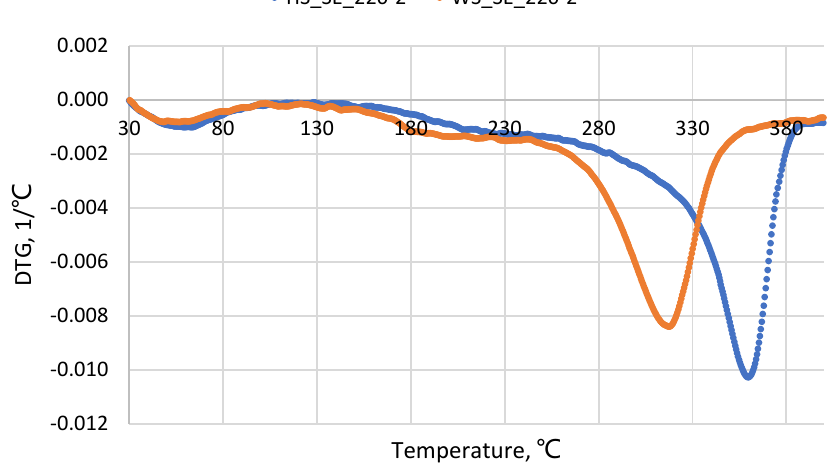
Figure 5. Derived thermogravimetry of steam-exploded (220 °C/2 min) HS and WS samples.